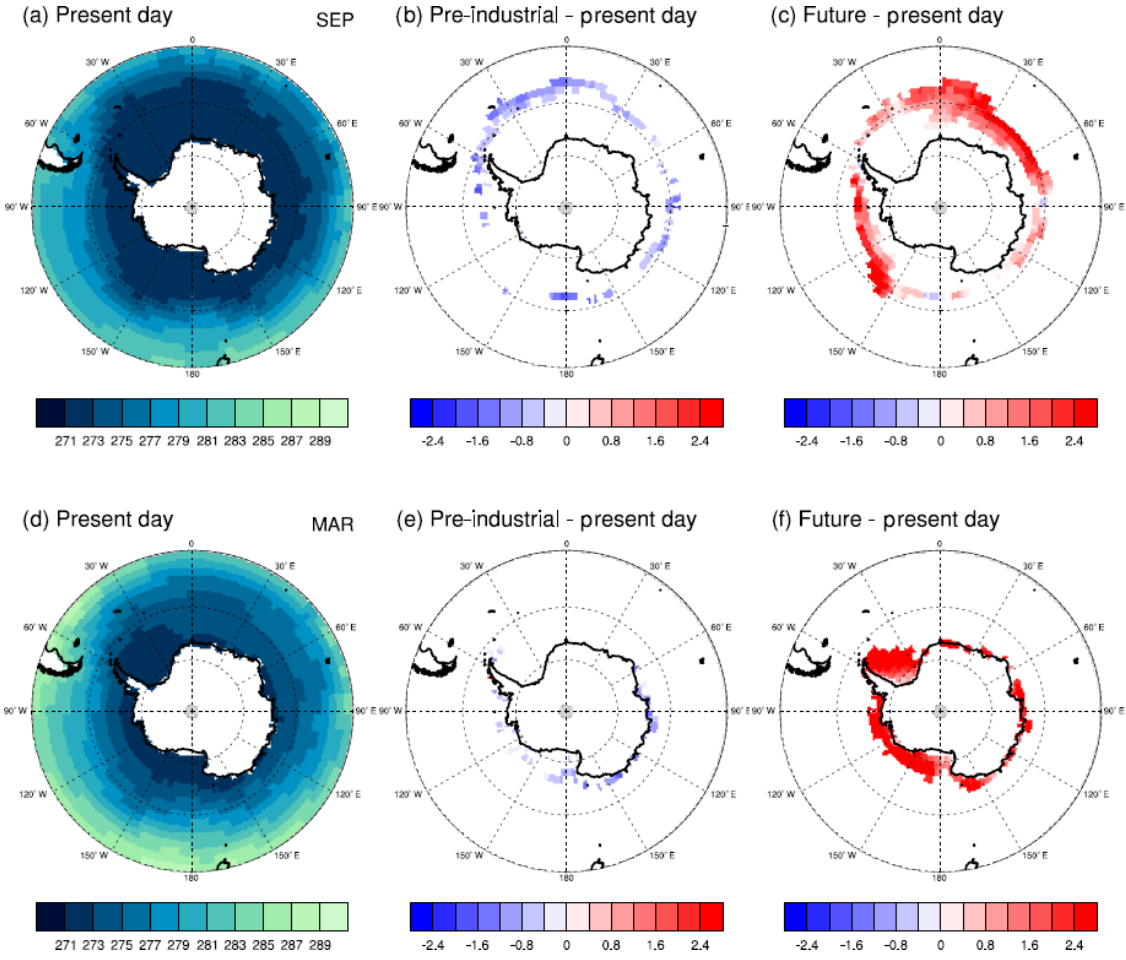
Figure 8. Antarctic SST forcing fields. Present-day Antarctic SST for (a) September and (d) March. Differences from present-day fields are shown for (b, e) pre-industrial and (c, f) future